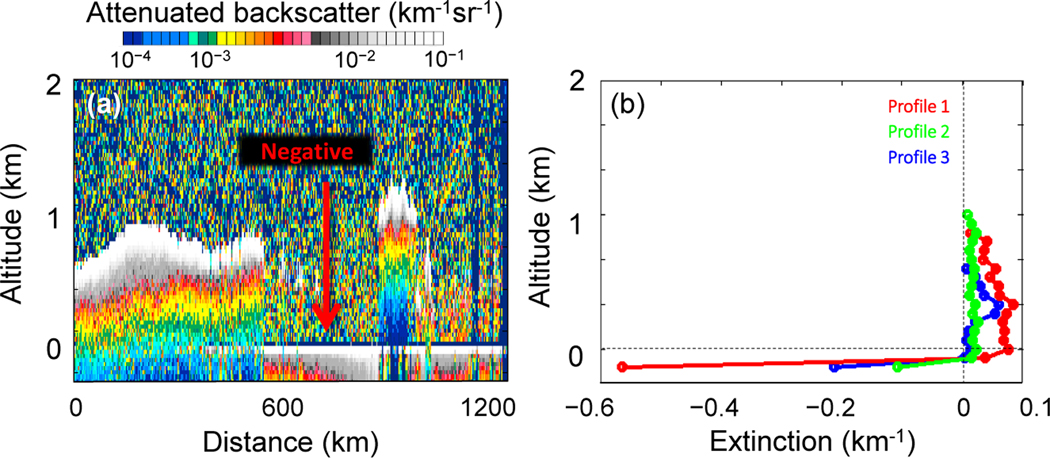
Example of NSA in the granule 2006–07-27T00–22-12ZN, centered at ∼ 25° S, 10.5° E. (a) Level 1B total attenuated backscatter. (b) Level 2 aerosol extinction profiles.